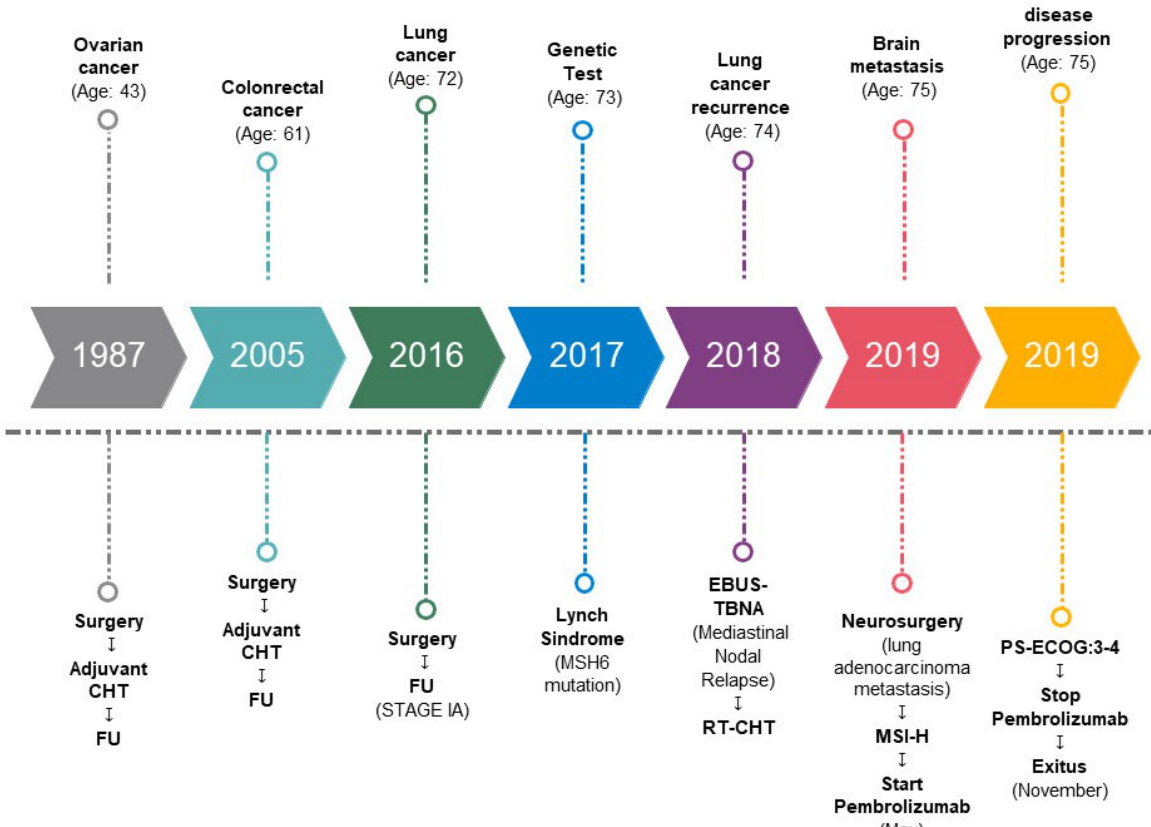
Figure 3. Timeline events. CHT: chemotherapy; FU: follow up; RT: radiotherapy; PS-ECOG: performance